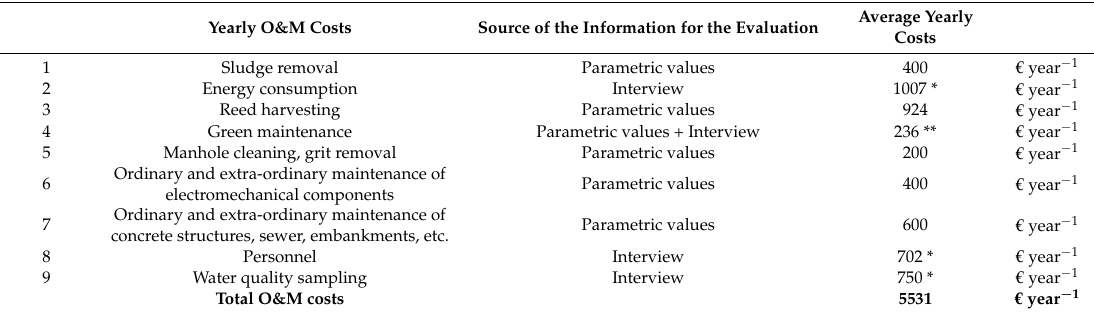
Table 5. Expenditure items considered for the O&M cost estimation and source of information used for the evaluation.